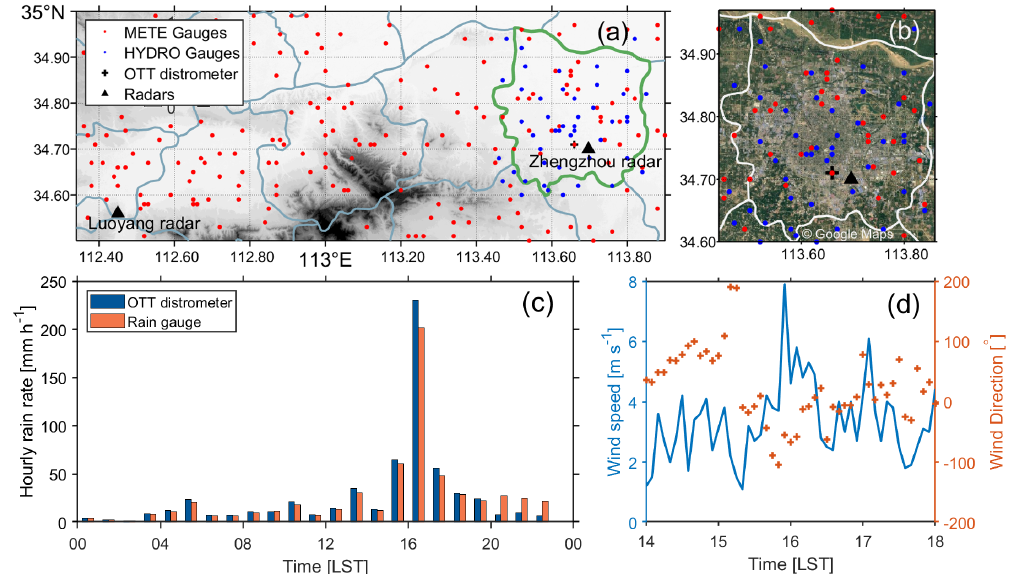
Figure 1. (a) Topography over and around Zhengzhou overlaid with the locations of the two operational S-band dual-polarization radars (black triangles), meteorological rain gauges (METE gauges; red dots), hydrological rain gauges (HYDRO gauges; blue dots), and one OTT Parsivel disdrometer (OTT; black cross); (b) a satellite image of Zhengzhou city (modified from Google Maps); (c) hourly rain rate recorded by the gauge and the OTT disdrometer located at the Zhengzhou national reference climatological station (34.71 ◦ N, 113.66 ◦ E; the site at which the OTT disdrometer was deployed) on 20 July 2021; and (d) the 5min horizontal wind speed (left axis) and direction (right axis) from 14:00 to 18:00LST. The light blue curves in panel (a) indicate county boundaries, and Zhengzhou city is outlined in dark green. Note that the HYDRO gauges are widely distributed, although only those over Zhengzhou city are presented in panel (a)